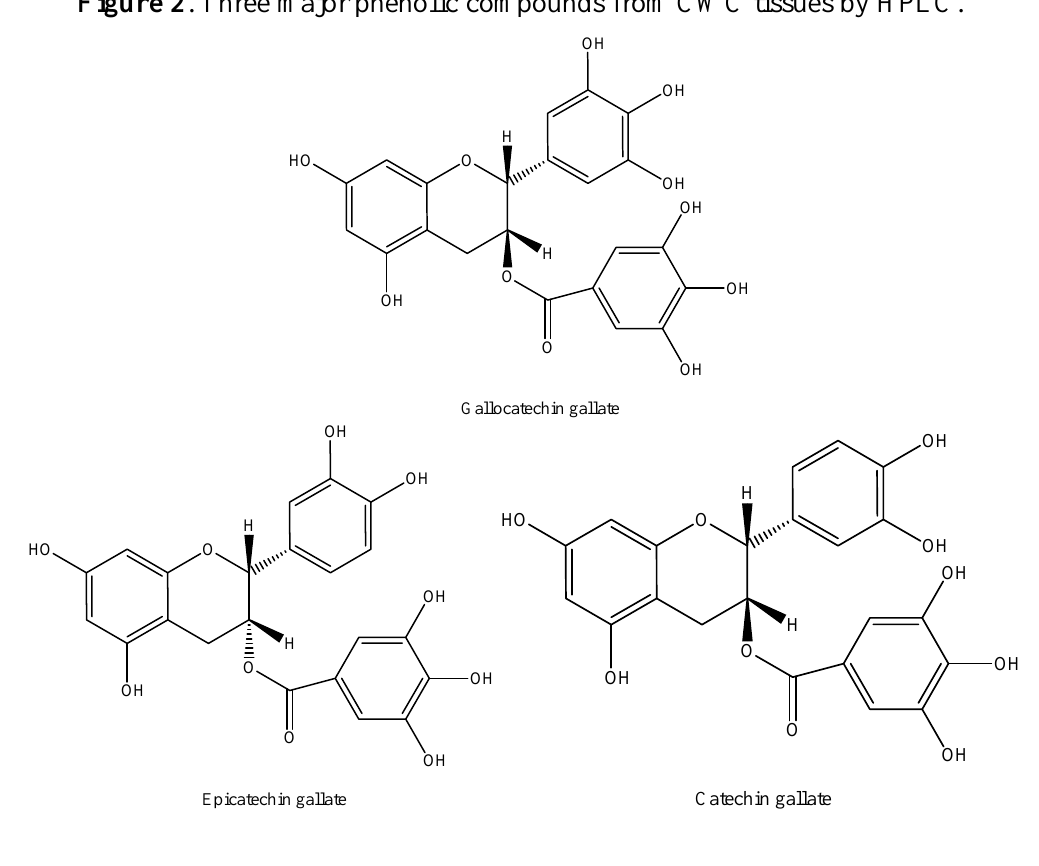
Figure 2 . Three major phenolic compounds from CWC tissues by